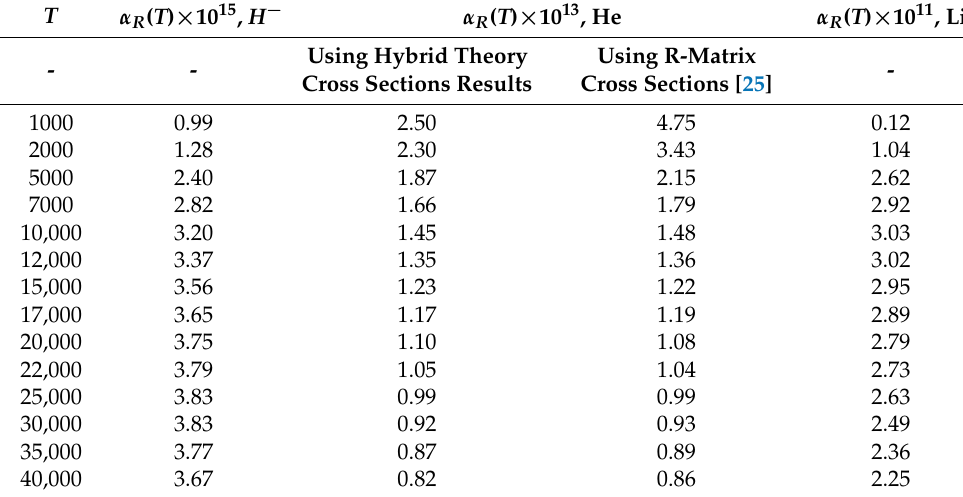
Using R-Matrix Cross Sections [25]